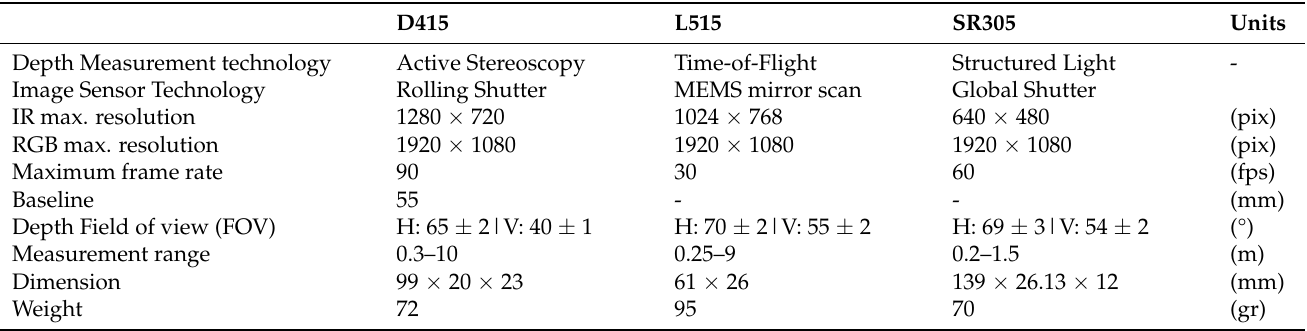
Table 1. Main specifications of the Intel ® RealSense™ cameras considered in this work.